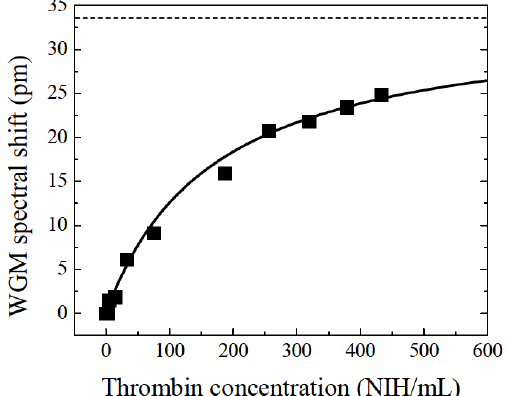
Figure 13. WGM spectral shift vs. thrombin concentration. Solid line: theoretical fit; dashed line: WGM shift for maximal thrombin binding. Reproduced with permission from [22] © 2006